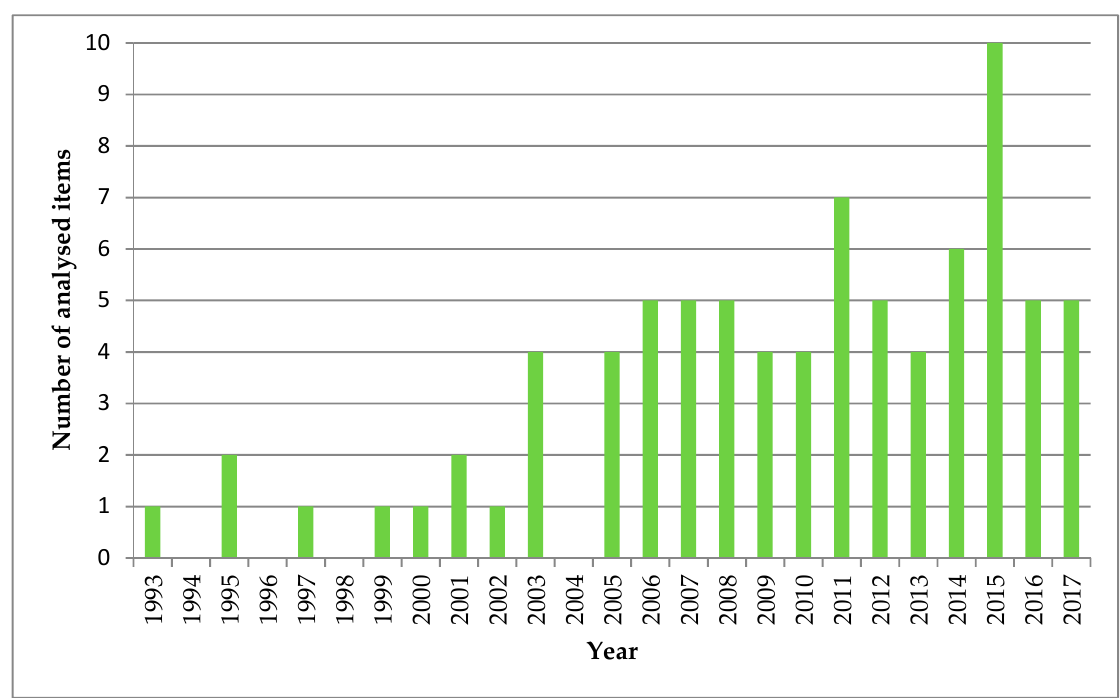
Figure 1. Time distribution of materials concerning the European region, cited in the results.